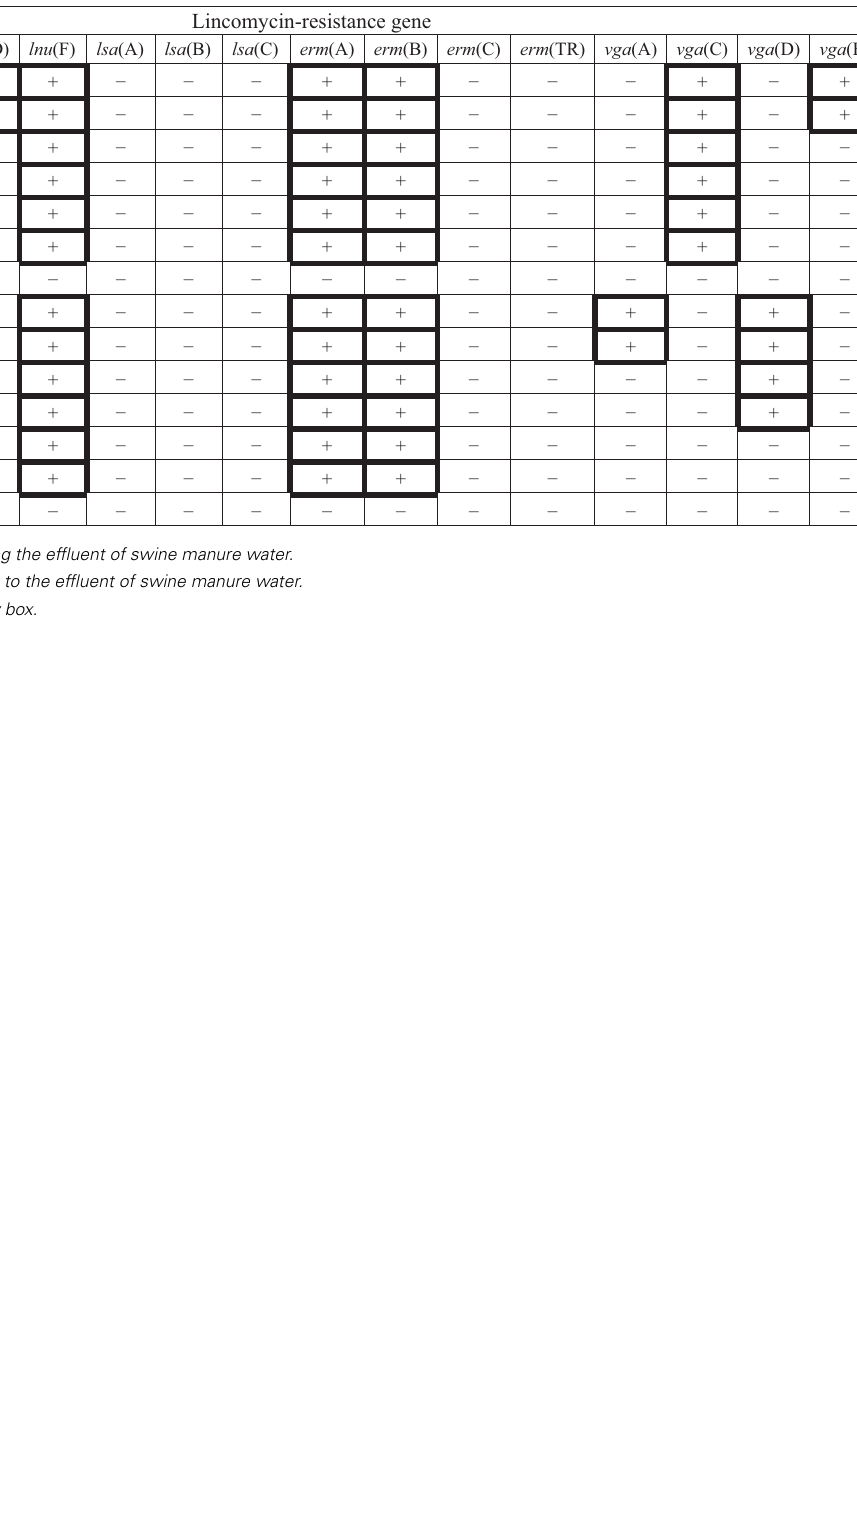
Table A2 | PCR detection results of lincomycin-resistance genes in total DNA.